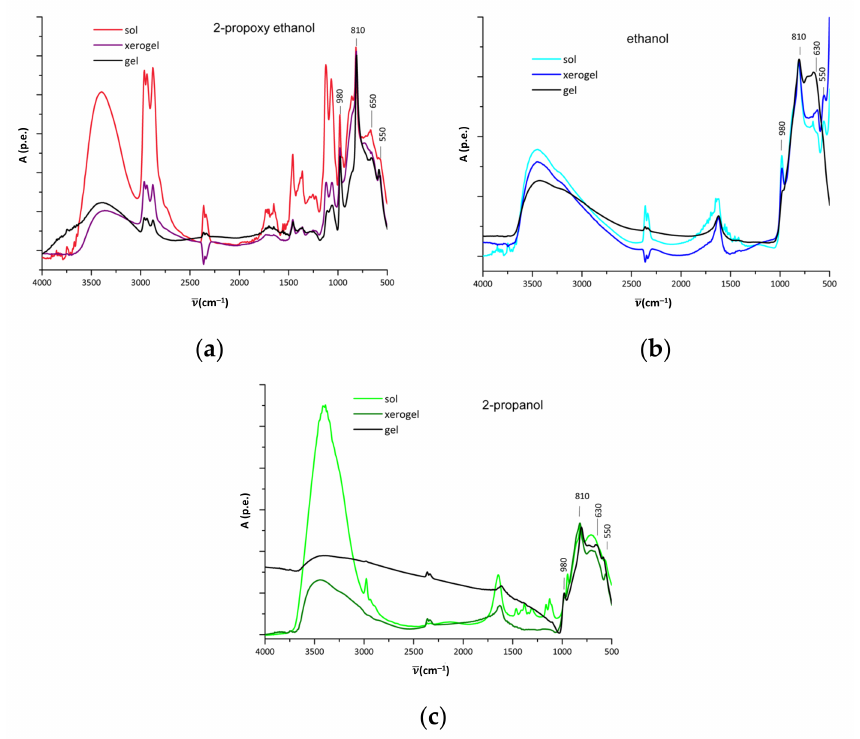
Figure 4. The IR spectra of the WO 3 sol, xerogel and gel prepared by different alcohols, ( a ) 2-propoxy ethanol, ( b ) ethanol and ( c )